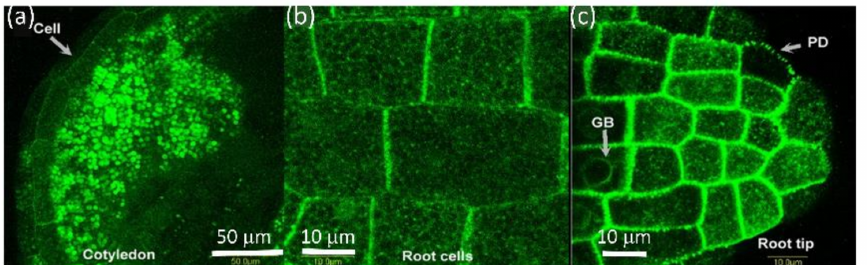
Figure 3. Distribution of PDLP5-GFP in imbibed seeds of tobacco. ( a ) Cotyledon-showing disappear- ance of PDLP5-GFP from outer cell layer after two days of imbibition. Bar = 50 µ m ( b ) close-up of root cells in four days imbibed tobacco seed showing the presence of PDLP5-GFP in the cell wall. Bar = 10 µ m ( c ) close-up of root tip cells in two days imbibed tobacco seed. Bar = 10 µ m. The bar shows the distance in µ m. GB = granular body; PD = plasmodesmata.